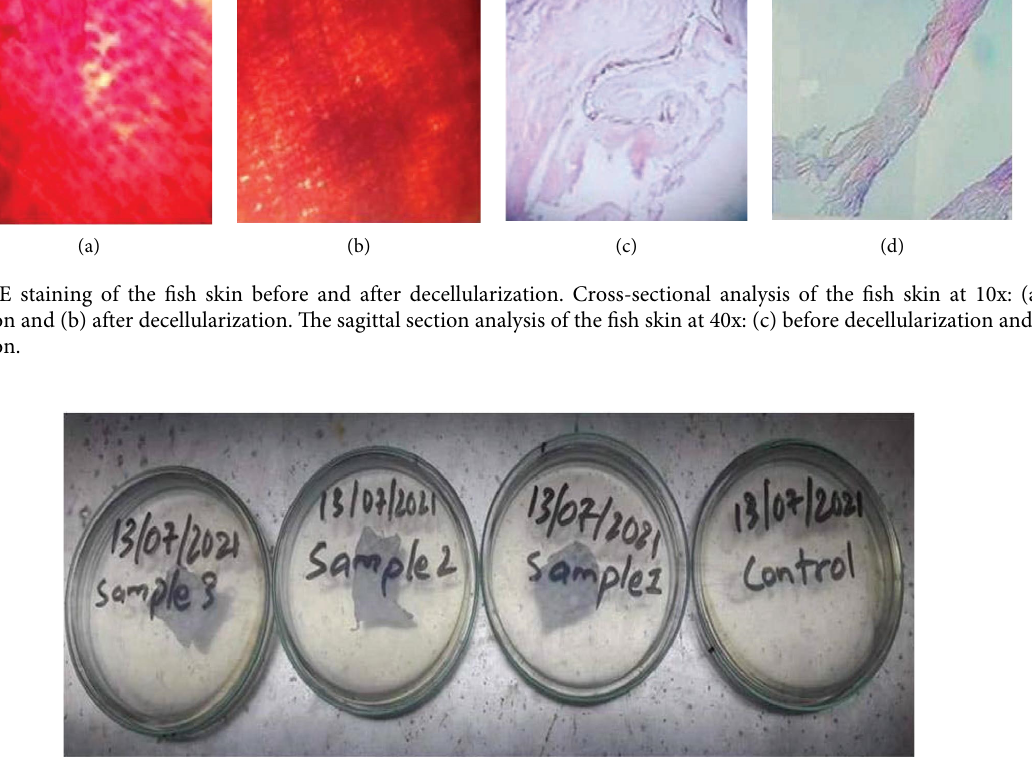
Figure 6: Te contamination test of DFS scafold. Te test was performed on three identical DFS scafolds, and there was no bacterial growth on the sample.